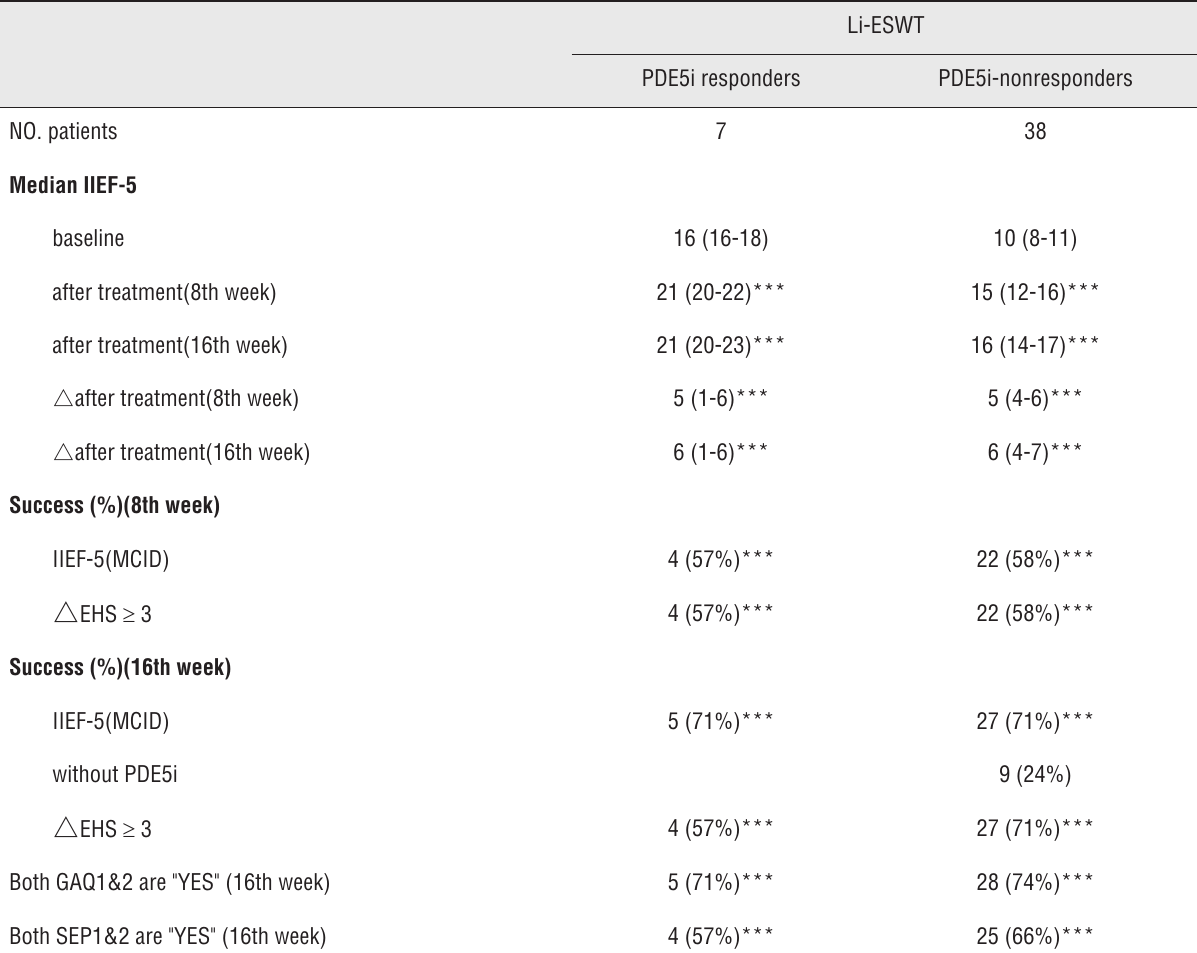
Table 2 - Treatment success of